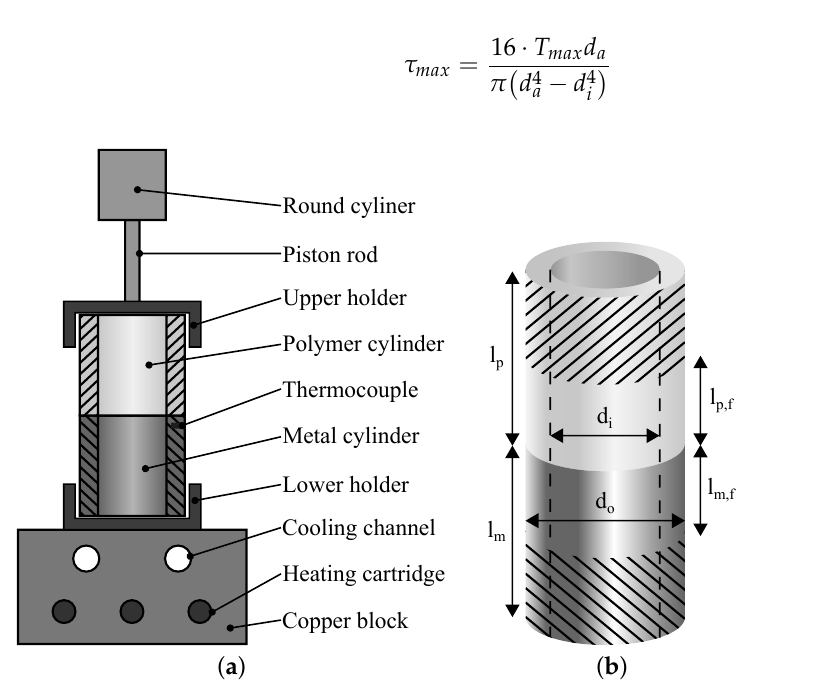
Figure 4. Hollow cylinder sample: ( a ) heat conduction hot pressing tool, ( b )